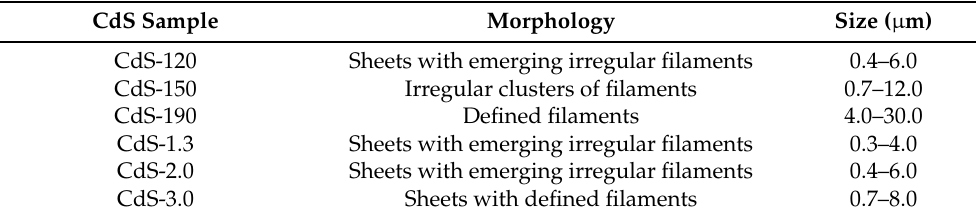
Table 3. Morphology and size of CdS samples derived from FE-SEM analysis.